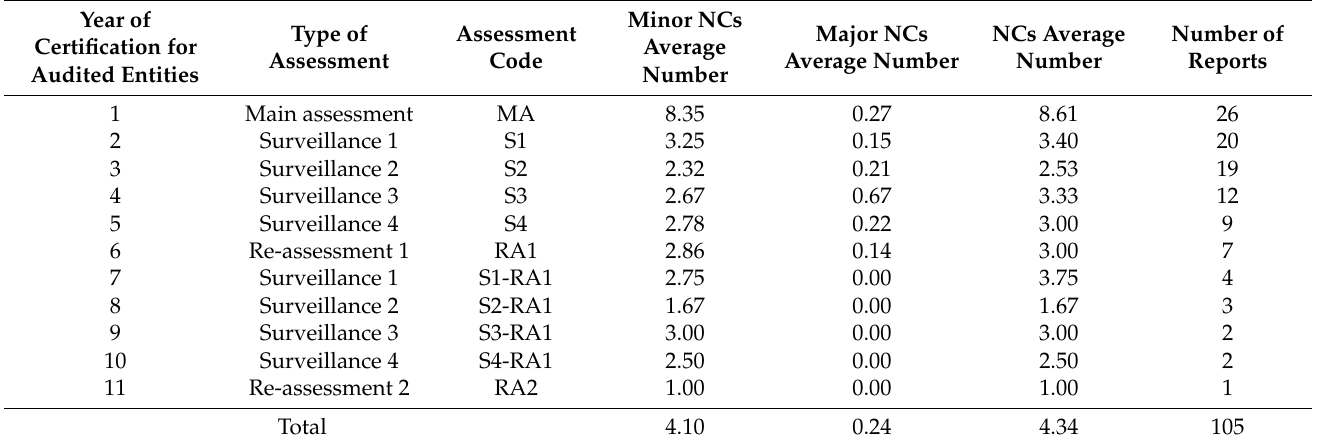
Table 2. Descriptive statistics of the analyzed assessment reports and non-conformities